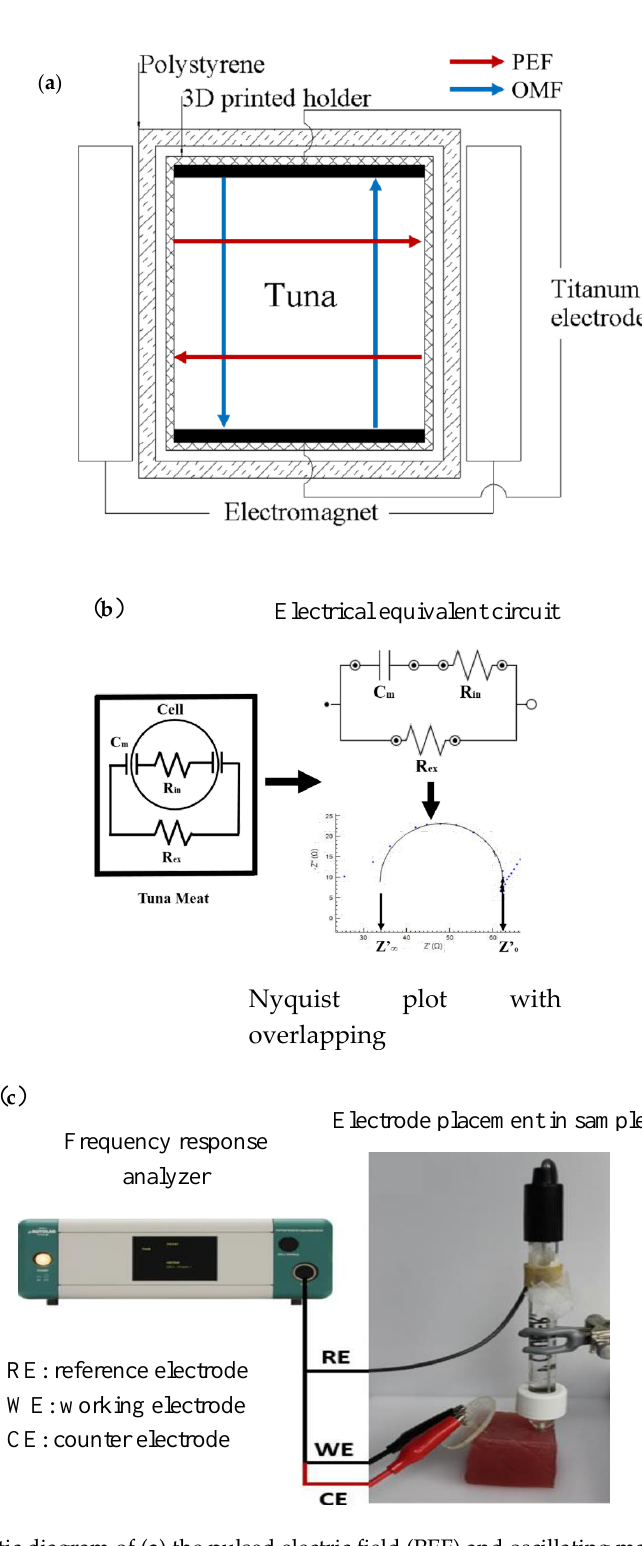
Figure 1. Schematic diagram of ( a ) the pulsed electric field (PEF) and oscillating magnetic field (OMF) supercooling system (arrows indicate the direction of the applied fields), ( b ) the electrical equivalence of tuna meat and its constituents (Fricke model), and the ( c ) electrochemical impedance spectroscopy (EIS) experiment